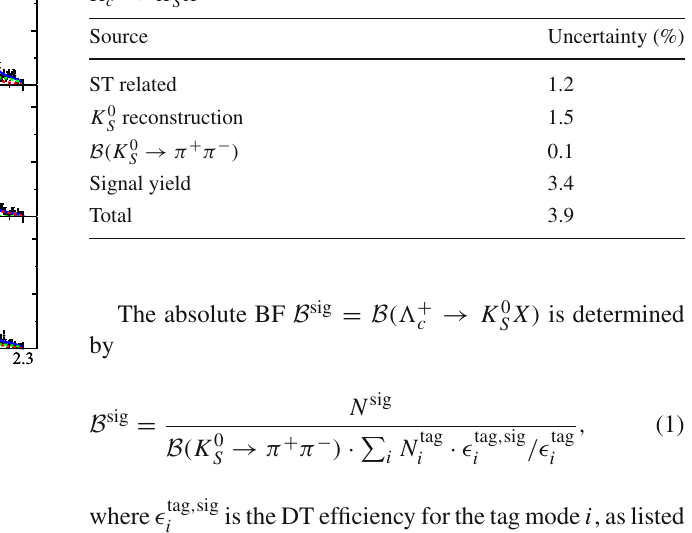
Table 3 Systematic uncertainties in the measurement of the BF of (cid:2)